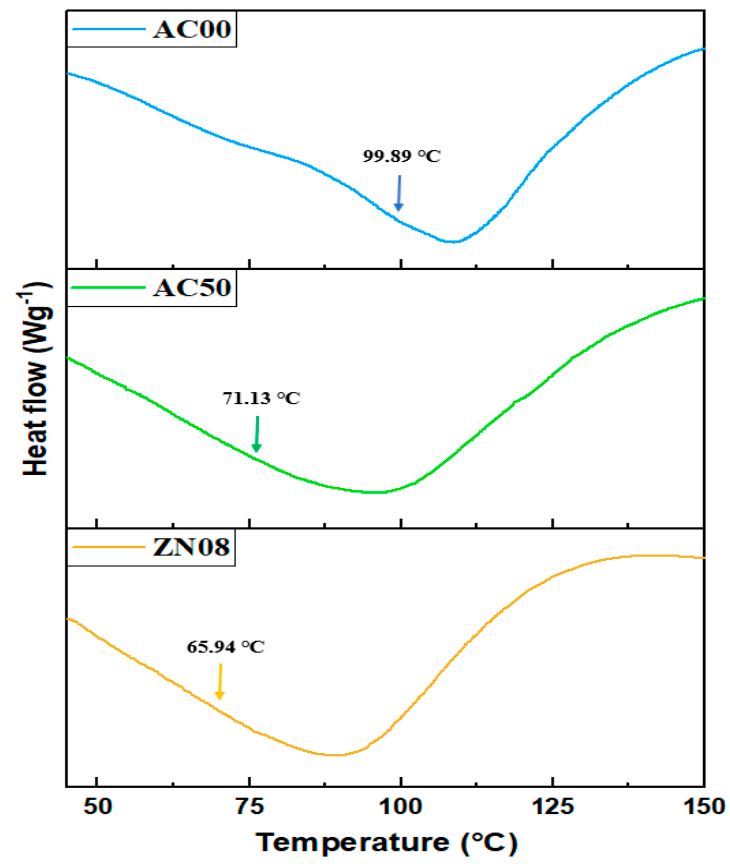
Figure 4. DSC thermograms for some selected samples.